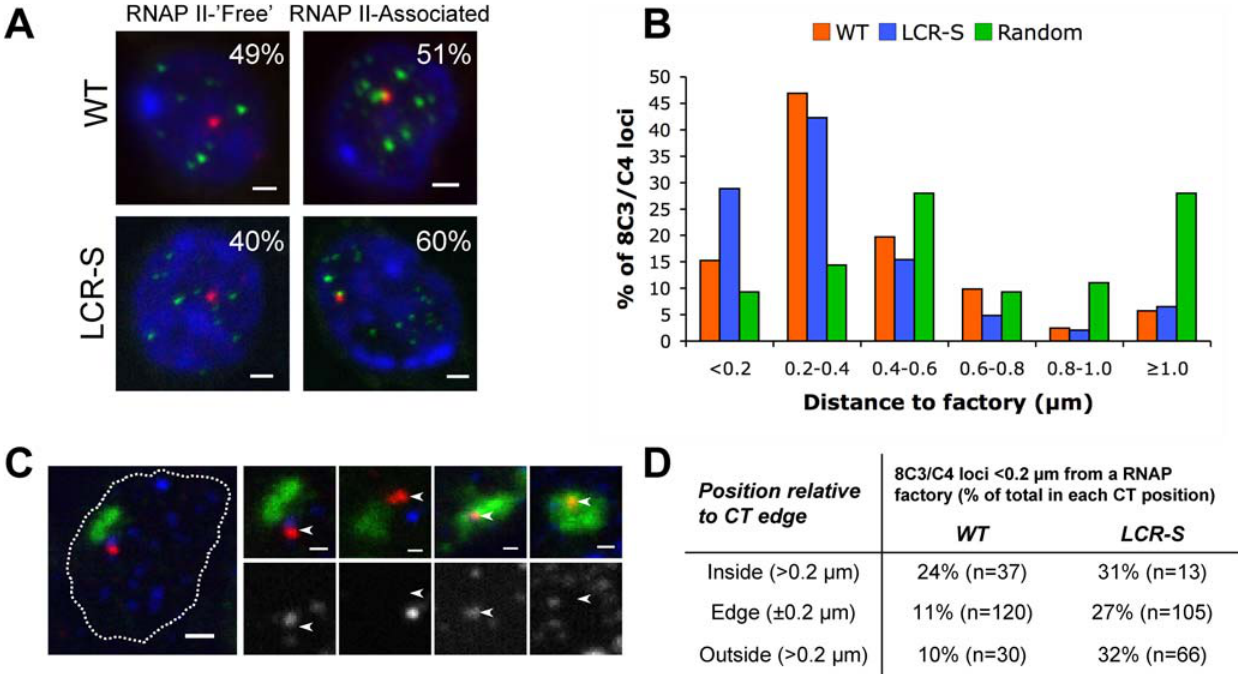
Figure 4. Effect of LCR insertion on the association of 8C3/C4 with transcription factories. (A) Nuclear sections from WT and LCR-S fetal livers (blue) were immunolabeled with an antibody against the Ser2-phosphorylated form of RNAP II (green), hybridized to the 8C3/C4 BAC probe (red), and the association of the locus with transciption factories was scored (n $ 231 loci). Bars, 1 m m. (B) To obtain an unbiased measurement of factory association, distances were measured between the centres of 8C3/C4 loci and the nearest RNAP II focus, showing significant differences in the distances distributions between WT and LCR-S loci (p=0.003, K-S test). Both loci are found in closer proximity to transcription factories than predicted by a random model (p , 0.001, K-S test), in which loci were randomly placed inside experimental images of RNAP II-labeled nuclei and distances measured. (C) The active form of RNAP II (blue or grayscale), 8C3/C4 (red; arrows) and chromosome 8 (green) were labeled as before. The nucleus is outlined by a white line. Bars, 1 m m. (D) Distances of 8C3/C4 loci to the nearest CT edge and transcription factory were measured after performing the triple labeling described above (C) in sections from WT and LCR-S fetal livers. The frequency of loci , 0.2 m m away from a transcription factory was calculated within each position relative to the